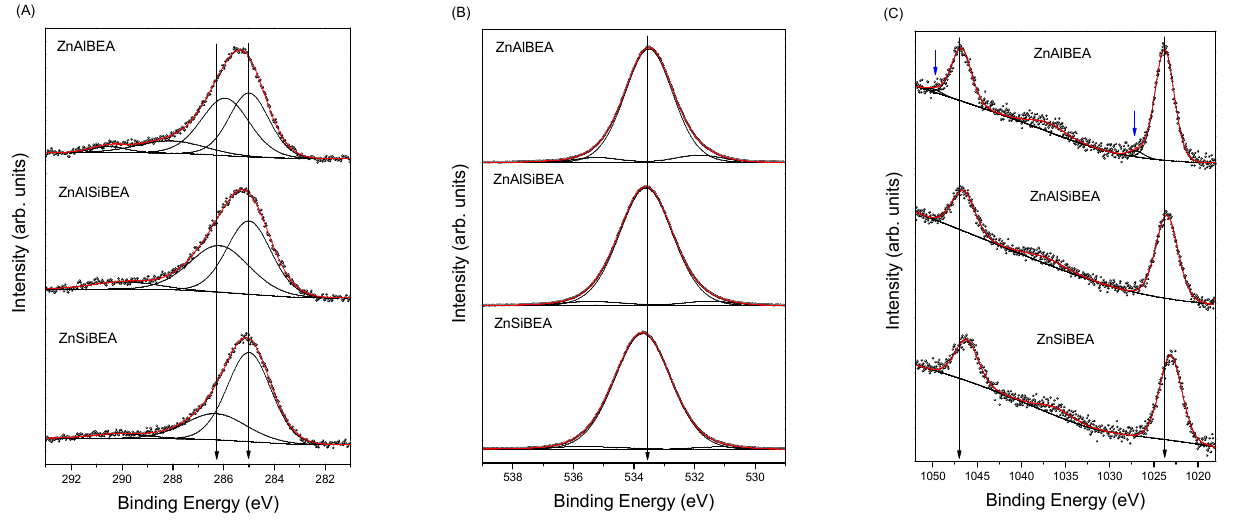
Figure 2. XPS spectra of Zn-BEA zeolites in the BE regions of C 1s ( A ), O 1s ( B ), and Zn 2p ( C ). Lines marking the most intense components. Blue arrows show an additional component in the Zn 2p spectrum of ZnAlBEA.